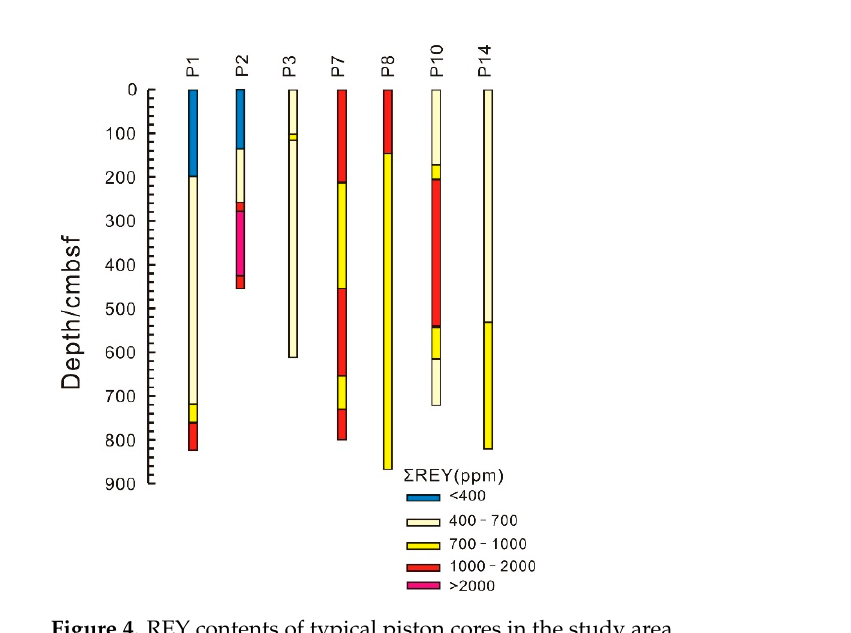
Figure 5. North American shale composite (NASC)-normalized REE patterns of deep-sea sediments in core P10. NASC after [32].